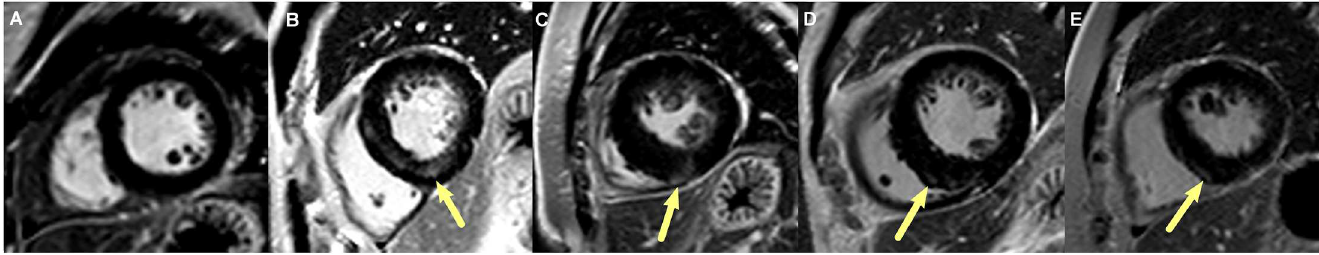
Fig 1. Images of variable patterns of delayed contrast enhancement on myocardium. a No delayedcontrast enhancement on myocardium is definedas the absenceof myocardialfibrosis. The patterns of myocardialfibrosis are diffuse (arrow, b ), patchy (arrow, c ), nodular(arrow, d ), or linear (arrow, e